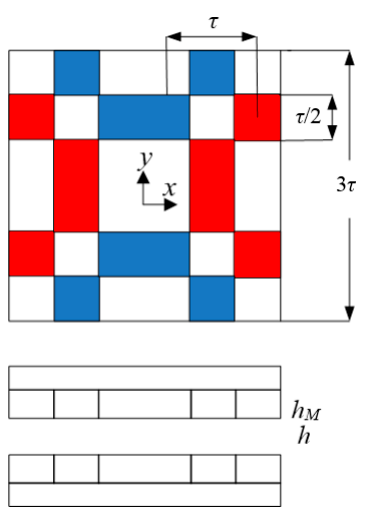
Figure 7. Top and side view of the planar motor.